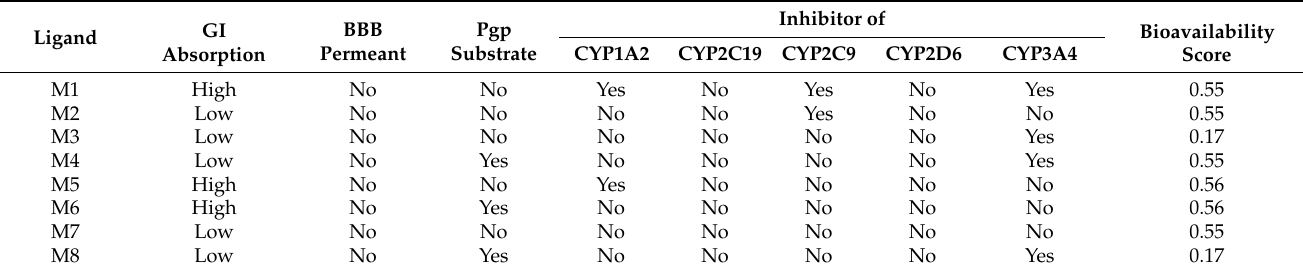
Table 6. Pharmacokinetic values of M. pendans compounds using